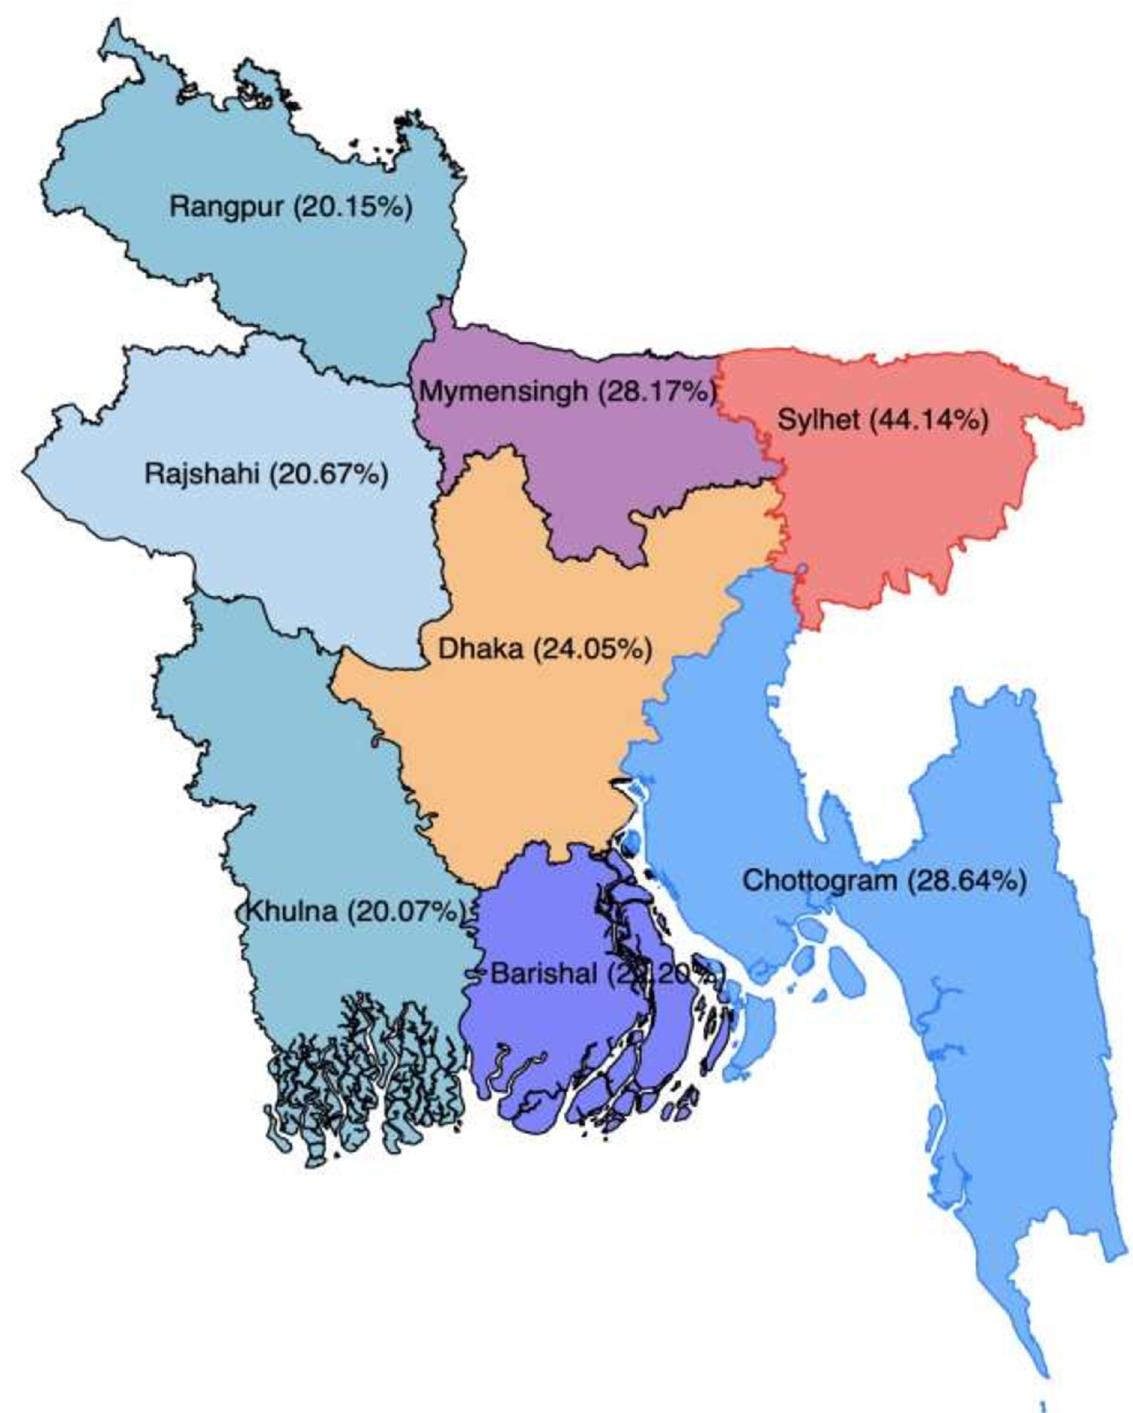
Fig 1. Age-standardised prevalence of short birth intervals in Bangladesh, BDHS 2017/18.